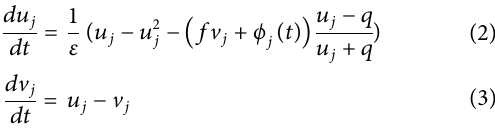
Frontiers in Chemistry |